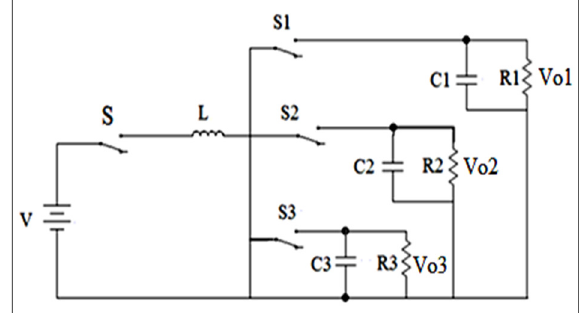
Fig. 10. Single input/multiple outputs circuit diagram.